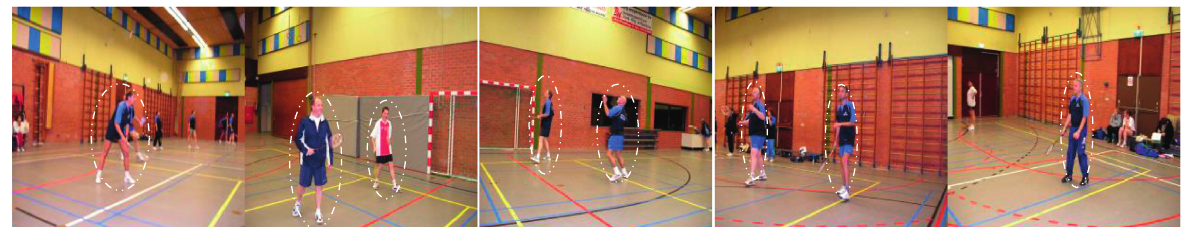
Figure 13: Partial results of human motion gesture capture based on video recognition.